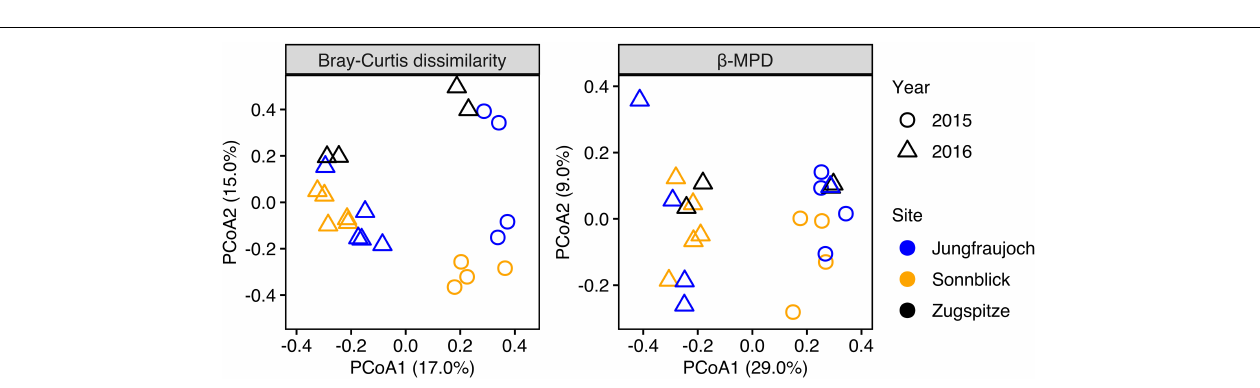
FIGURE 5 | Microbial community composition across snowpack profiles per site and year based on relative abundances summarized at class level. The range of pooled layers used for DNA extraction is indicated in cm above the bottom of the snowpack. For clarity of display, classes with a combined relative abundance < 5% across all samples are shown collectively as “Diverse